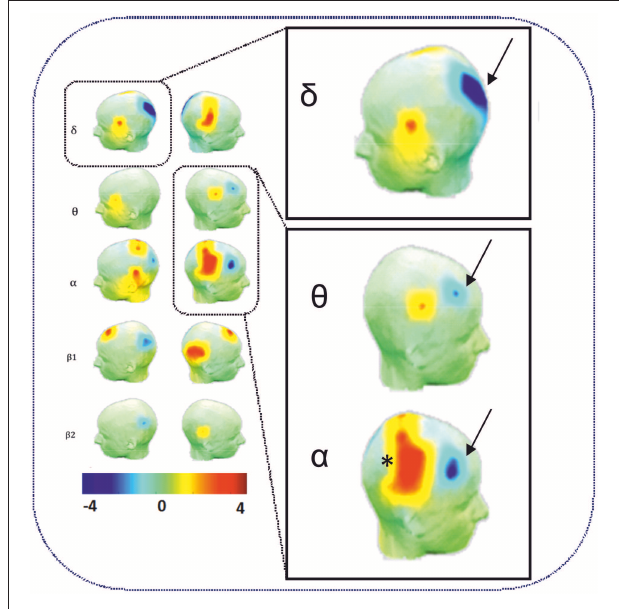
FIGURE 2 | Power spectrum analysis of functional disorganization in the epileptogenic zone in remote regions. (Right Top) Increase in δ , θ , and α power spectra (arrows) in the epileptogenic zone over the centro-temporal areas in the presence of IES. (Right Bottom) Relative decrease in power value (arrows) in θ and α frequency bands in frontal areas and in δ bands in occipital areas. Statistical difference ( t -value) maps of degree differences between HD EEG segments with IES and HD EEG segments without IES. The color bar indicates the t values projected onto a standardized head shape. The significant increase (indicated by red) and decrease (indicated by blue) in degree have been represented by positive and negative t values resulted from statistical comparisons between IES condition and no IES condition [adapted from Adebimpe et al. (127), reproduced under the Creative Commons CC-BY license]